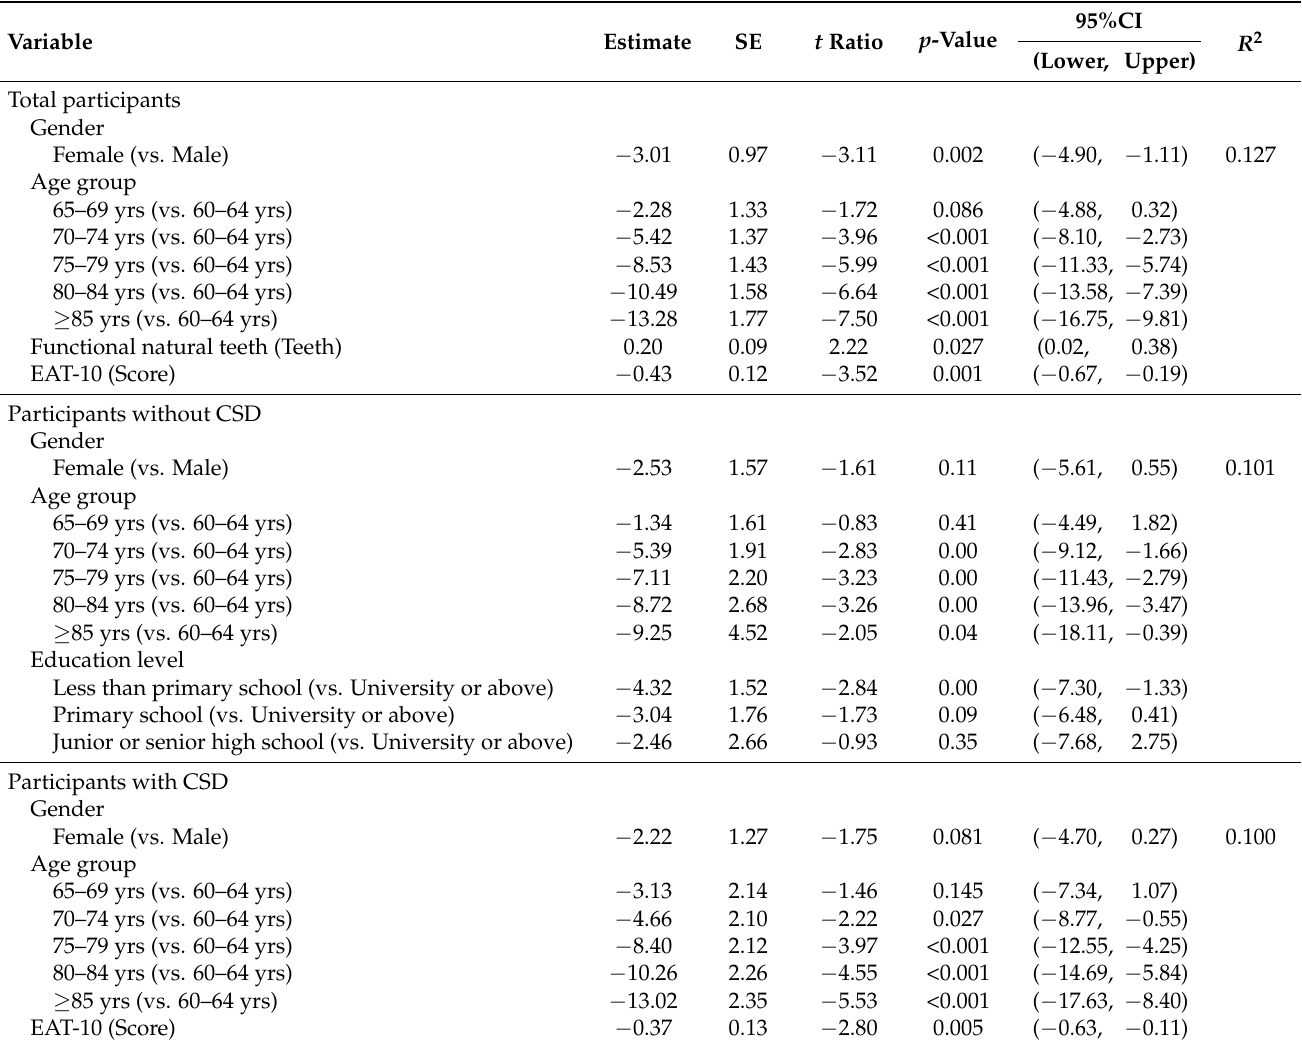
Table 4. Factors affecting tongue pressure of